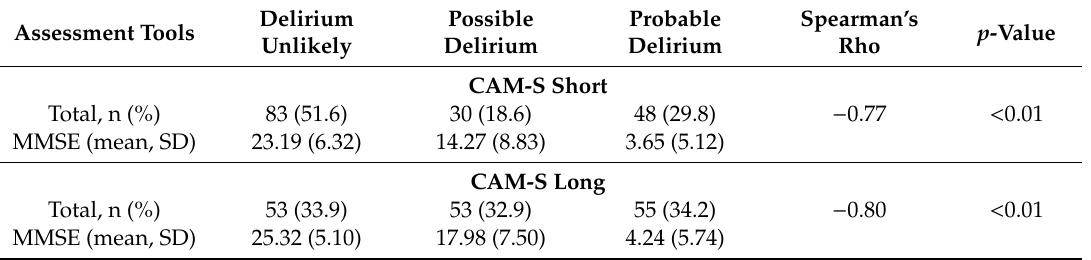
Table 3. Confusion Assessment Method-Severity (CAM-S) Short and Long Form and mini-mental test examination (MMSE) scores.